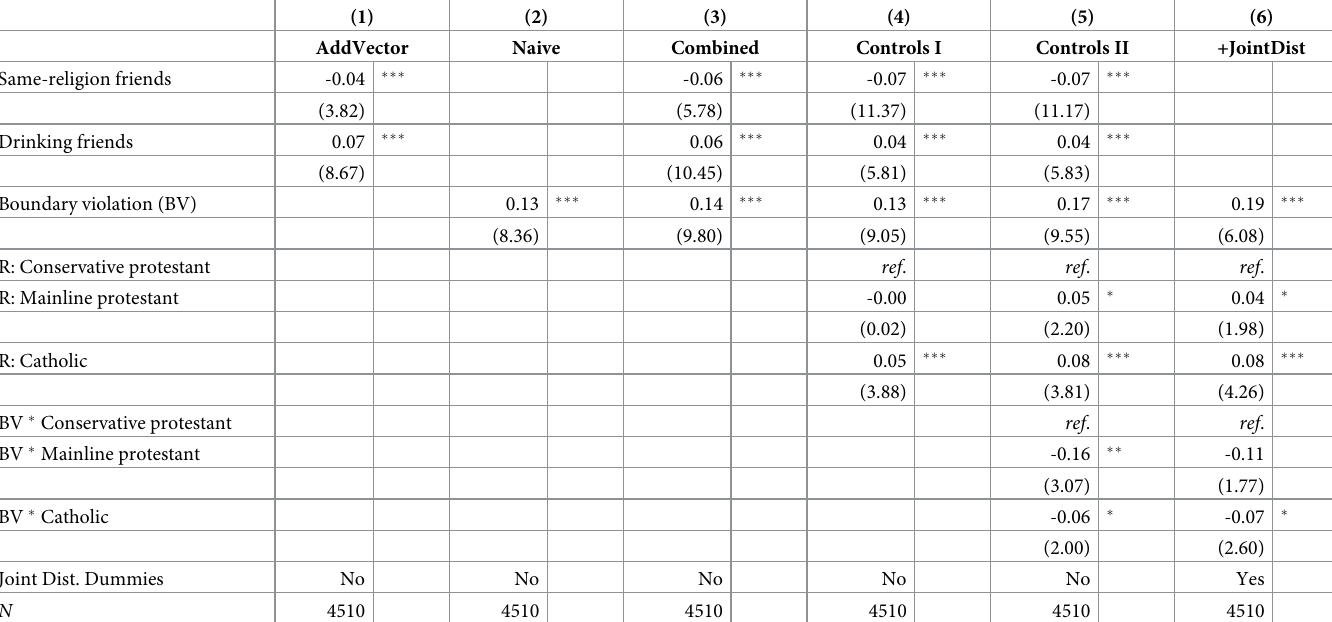
Table 1. Linear probability models of